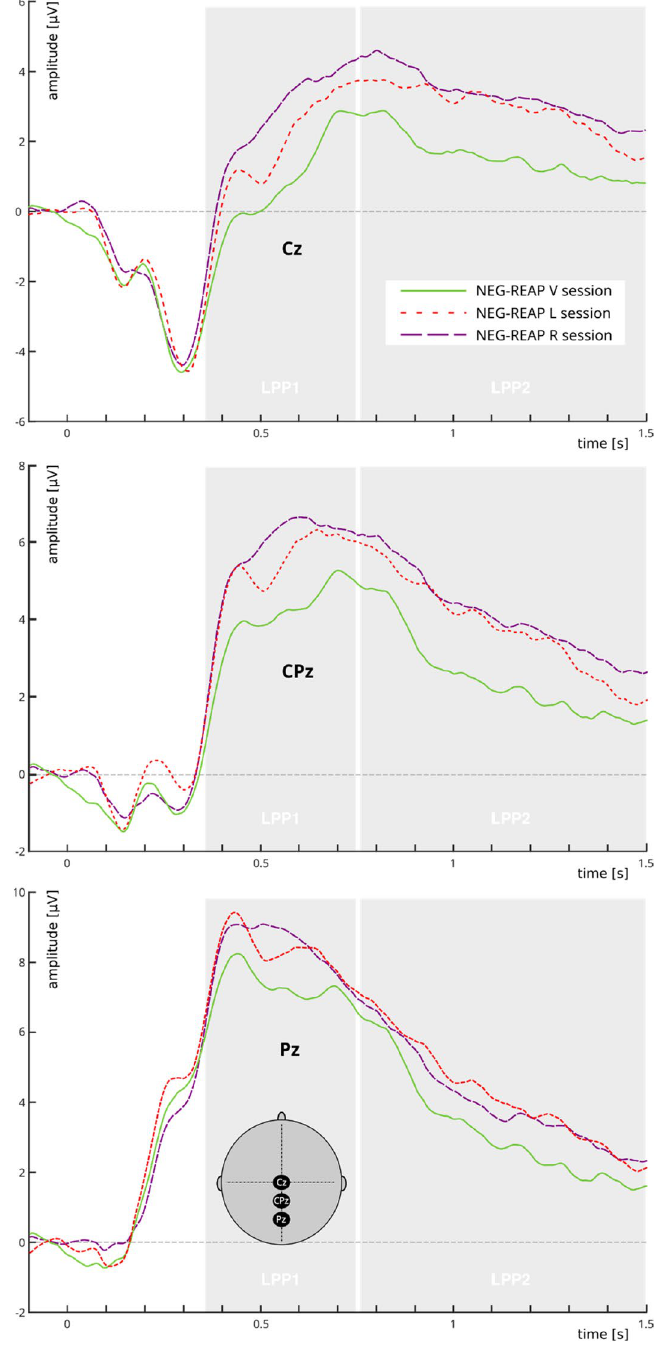
Figure 2. Picture-locked grand average waveforms at electrodes Cz (upper plot), Cpz (middle plot), and Pz (lower plot) for the reappraisal conditions (NEG-REAP) after the three TMS sessions (L, R, V). Shaded gray areas indicate the LPP time-windows submitted to statistical analysis (LPP1: 350–750 ms, LPP2: 750–1500 ms). Time zero on the x-axis indicates picture onset. The x-axis runs from the beginning of the baseline (100 ms prior to picture onset) to 1500 ms after picture onset. The EEG montage for the considered electrodes is